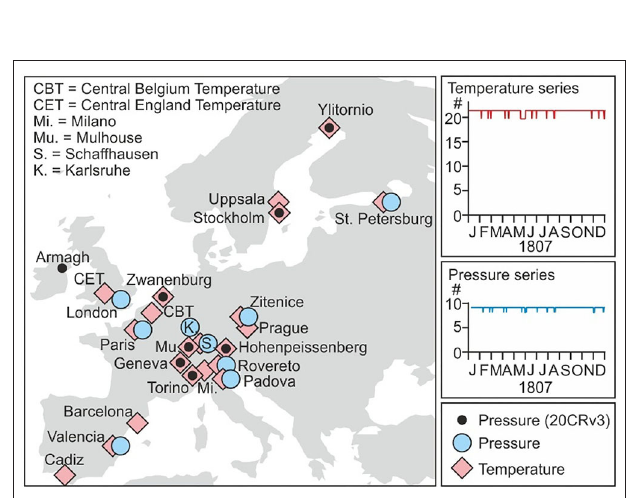
FIGURE 2 | Map of daily time series used in the experiments of the year 1807. Black dots indicate the pressure series already assimilated into 20CRv3. The colored symbols indicate stations assimilated in this article. Time series indicate the number of assimilated series per